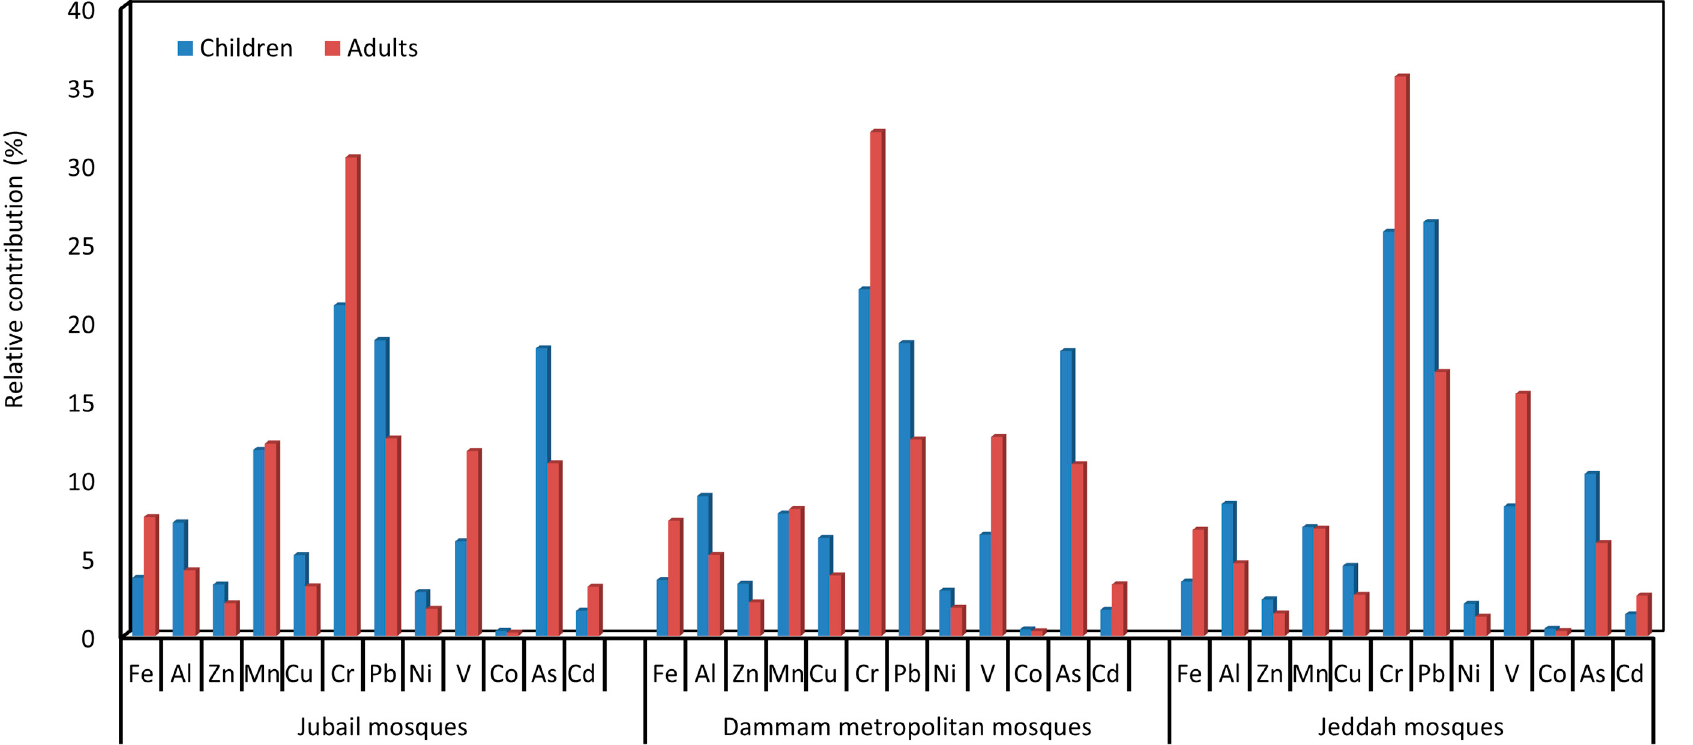
Figure 7. Relative contribution of the individual PHE hazard index (HI) to ∑ HI for total PHEs in Jubail, Dammam metropolitan, and Jeddah mosques for children and adults.